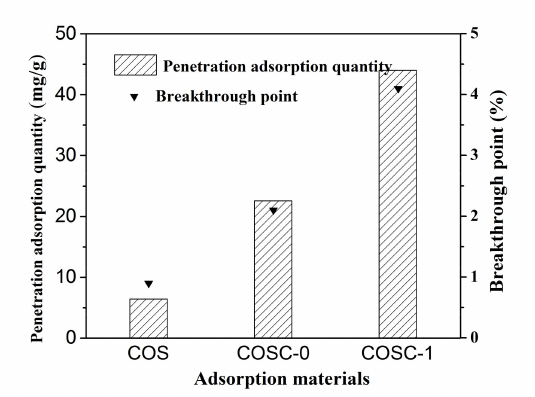
Figure 3. Adsorption quantity of different adsorbents for cooking fumes ( GHSV : 4300/h, T = 25 ◦ C, C 0 = 90 mg/m 3 , H = 30